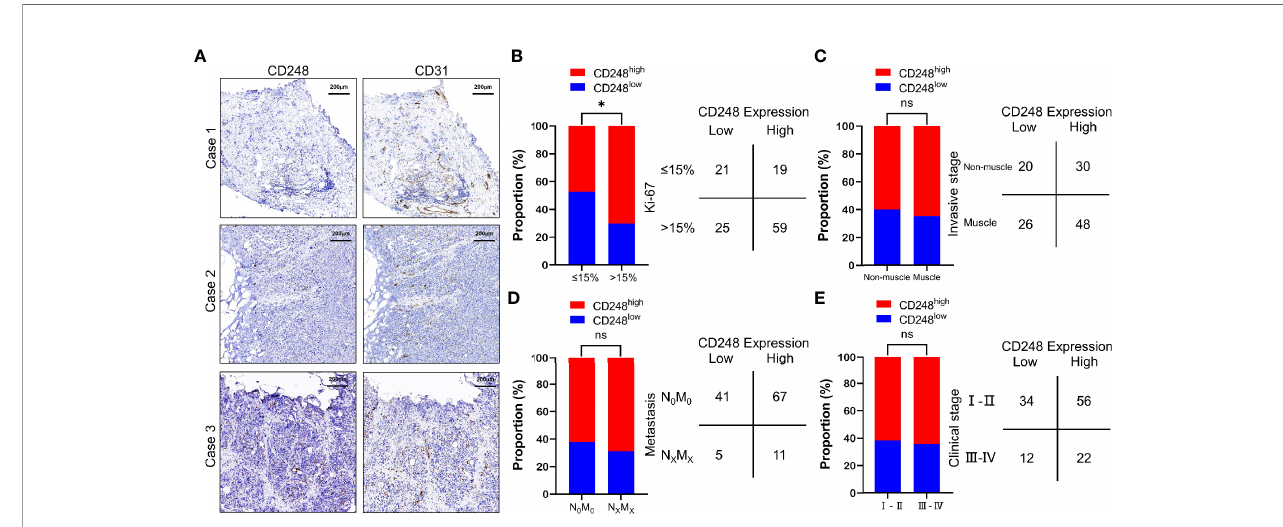
FIGURE 2 | CD248 expression in the tumor-associated vasculature of UCB and the comparison with clinicopathological parameters. (A) Representative IHC staining to show different CD248 expression levels in HCC, using CD31 as the positive control. Case 1: No CD248 expression (score = 0), Case 2: Positive CD248 expression in ≤ 50% of the tumor-associated vasculature (score = 1), and Case 3: Positive CD248 expression in >50% of the tumor-associated vasculature (score = 2). (B) Comparison between CD248 expression and the Ki-67 index. (C) Comparison between CD248 expression and invasive stage. (D) Comparison between CD248 expression and metastasis. (E) Comparison between CD248 expression and clinical stage. Scale bar = 200 m m. Representative images are shown. *P < 0.05; ns, no statistically signi fi